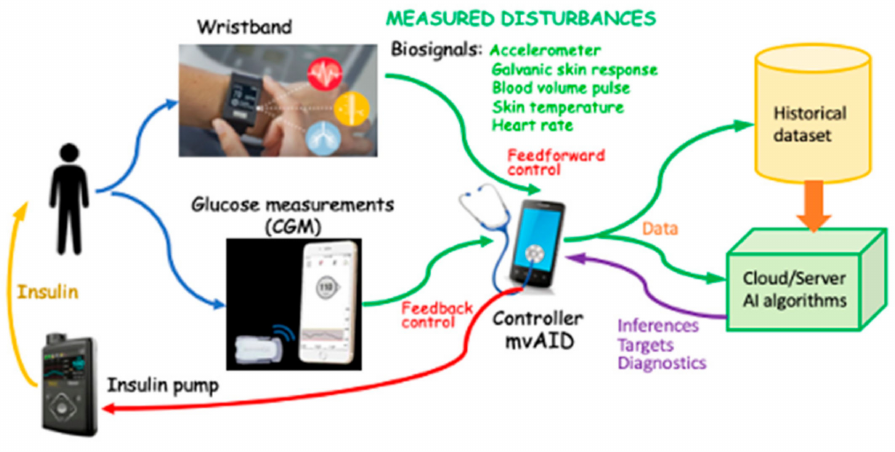
Figure 1. Devices and information flow in multivariable automated insulin delivery systems. Histori- cal data set depository and cloud/server for AI algorithms are used to improve glucose control by incorporating information on identified historical